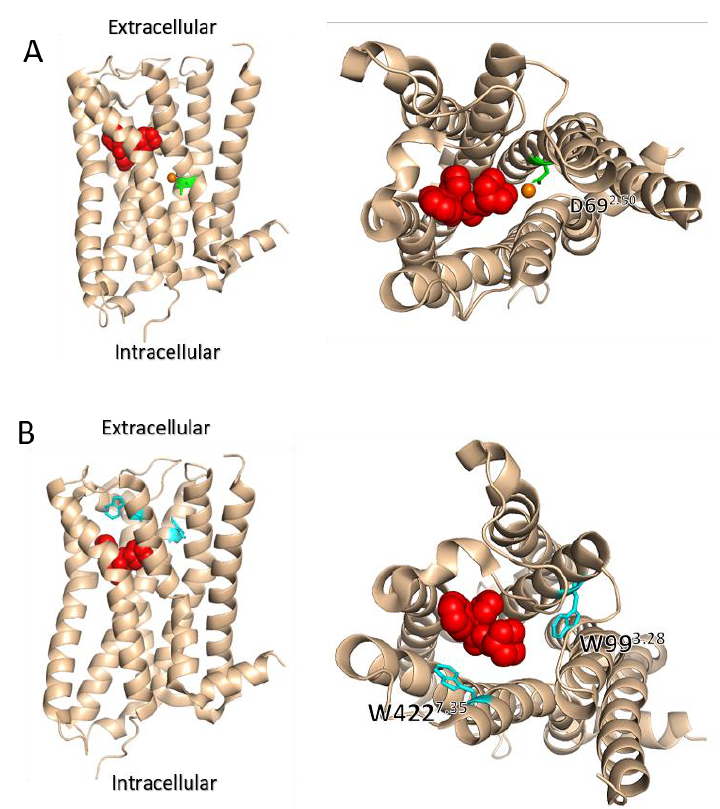
Figure 3. Side (left) and top (right) view of the M2R bound to an antagonist (red). In ( A ) Na + ion is shown in orange in its predicted location, and residue D69 2.50 (which was implicated in Na + binding) is shown in green. In ( B ), two residues that are part of the allosteric site and were implicated in voltage sensing are shown in cyan.